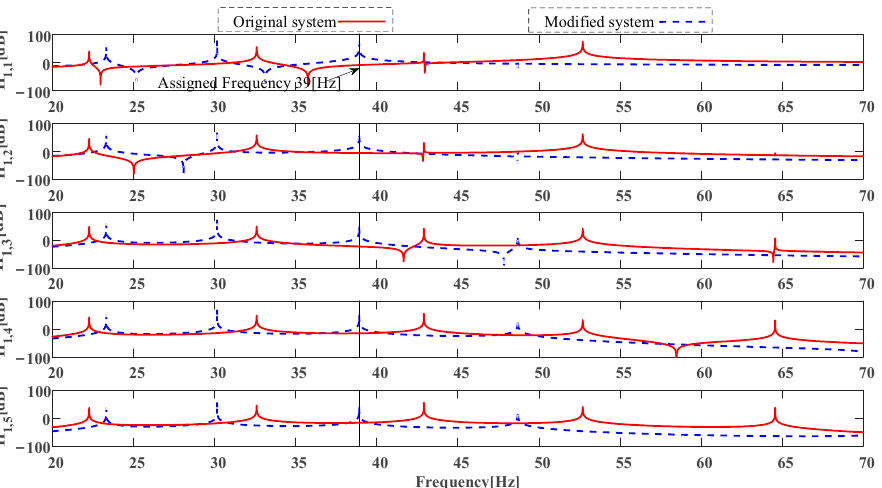
Figure 19. Original FRFs and FRFs after the simultaneous addition of masses and supporting stiffness . Table 12. Comparison of natural frequencies and mode shapes.